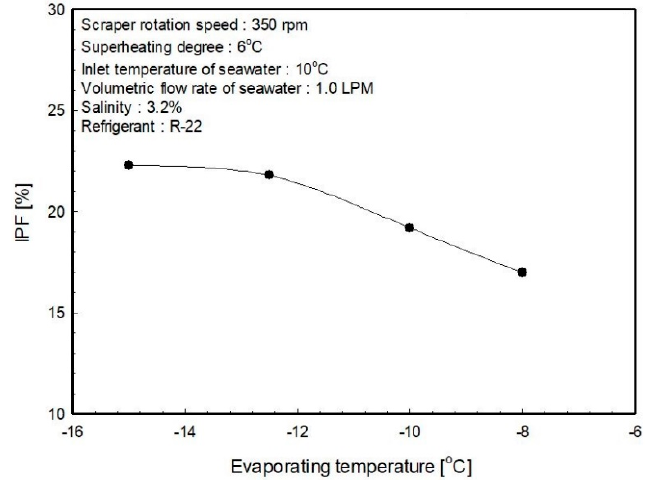
Figure 8. Temperature of ice slurry with seawater according to evaporating temperature.